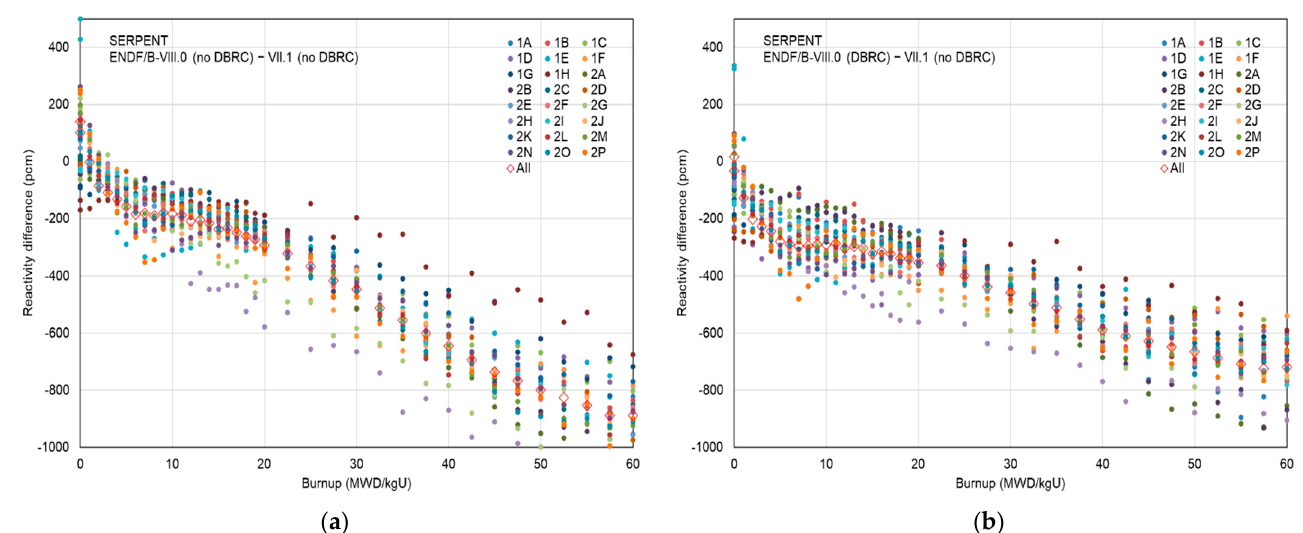
Figure 1. Comparison of the multiplication factors as a function of burnup: ( a ) the reactivity difference between ENDF/B- VIII.0 without DBRC and ENDF/B-VII.1 without DBRC; ( b ) the reactivity difference between ENDF/B-VIII.0 with DBRC and ENDF/B-VII.1 without DBRC.